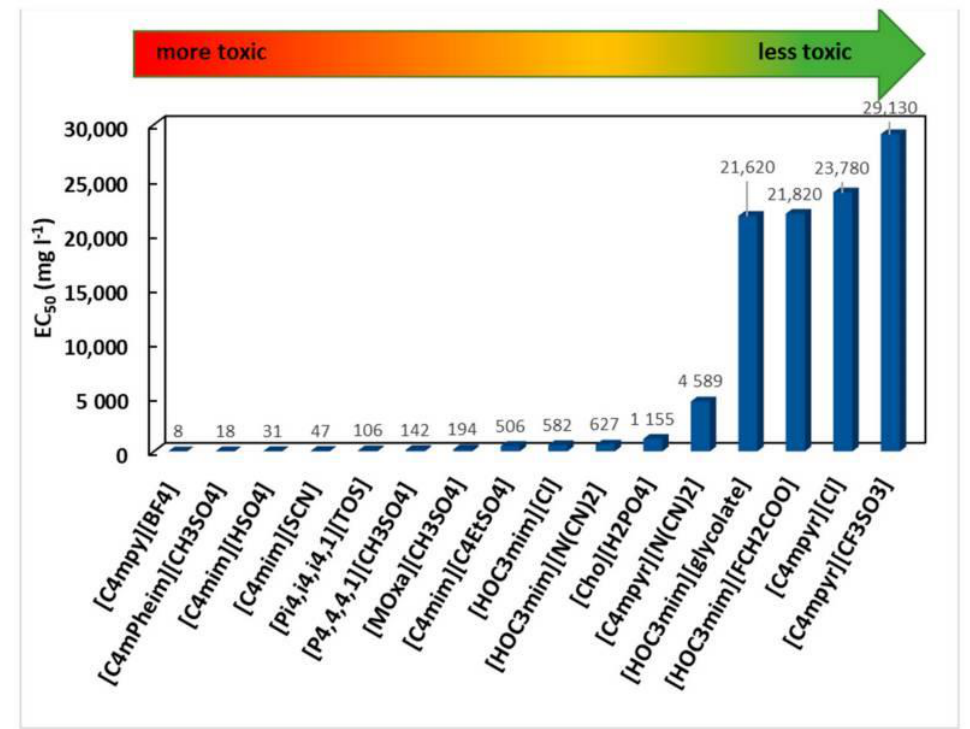
Figure 7. EC 50 values for ILs towards A. fischeri studied by Hernández-Fernández et al. Reprinted with permission from Ref. [136] 2021, Creative Commons CC BY4.0. Original data obtained with permission from Ref. [137]. 2015, Elsevier.